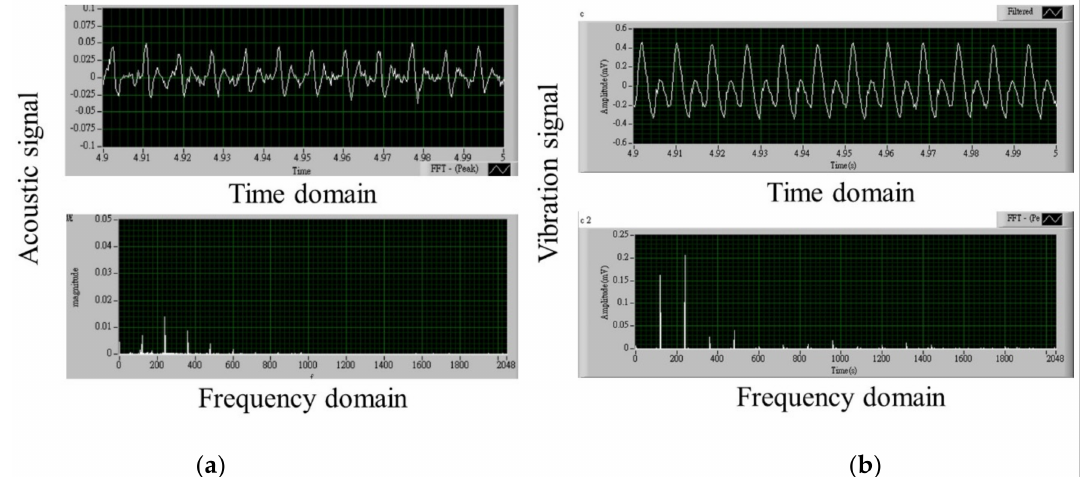
Figure 13. IoT PLC smart-factory-monitoring field in acoustic and vibration with Fog computing platform: ( a ) acoustic signal and ( b ) vibration signal.